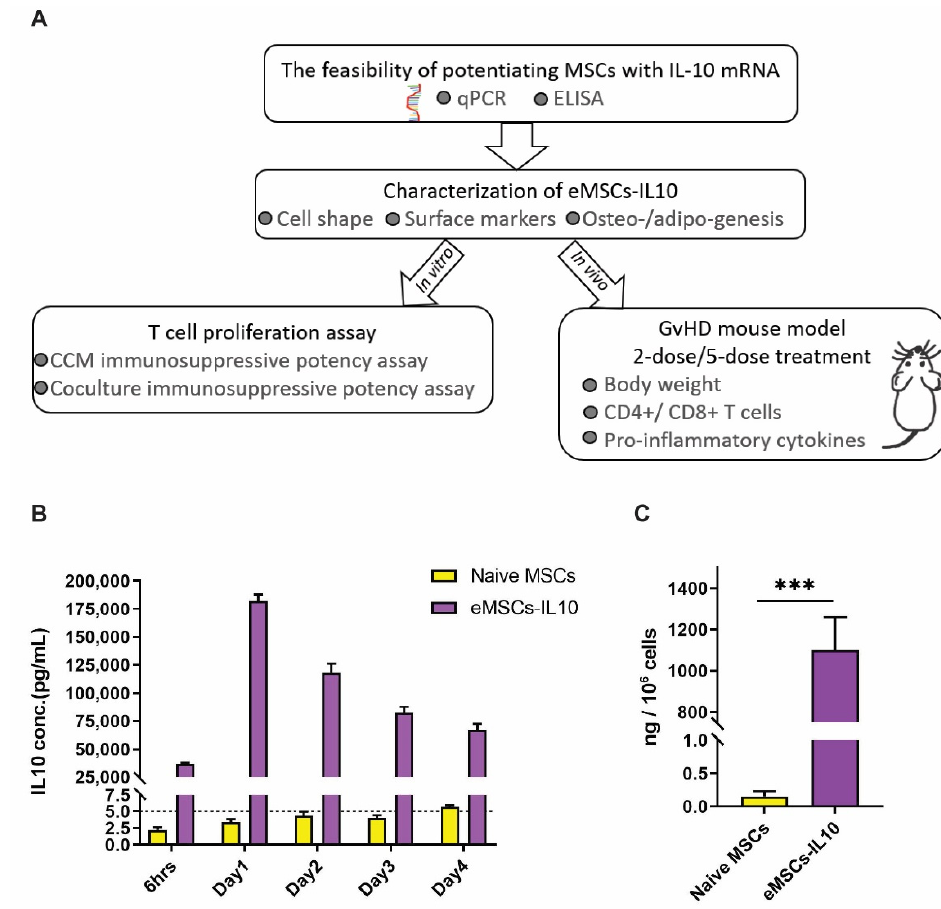
Figure 1. Characteristics of IL-10 secretion from eMSCs -IL10. ( A ) Summary schematic diagram illustrating the workflow of evaluating the immunosuppressive effects of eMSCs-IL10. ( B ) IL-10 secretion from eMSCs-IL10 lasts for at least 4 days. The culture supernatant was collected after 6 h and days 1, 2, 3, and 4 after mRNA transfection. A robust release of IL-10 after mRNA transfection was observed and the peak expression appeared after 1-day culture. Data shown as mean ± SD ( n = 4). ( C ) The amount of IL-10 released from thawed eMSCs-IL10 after 1-day culture. The cryopreserved naïve MSCs and eMSCs-IL10 were thawed and then cultured for 24 h. Data presented as mean ± SD ( n = 3), *** p < 0.001.